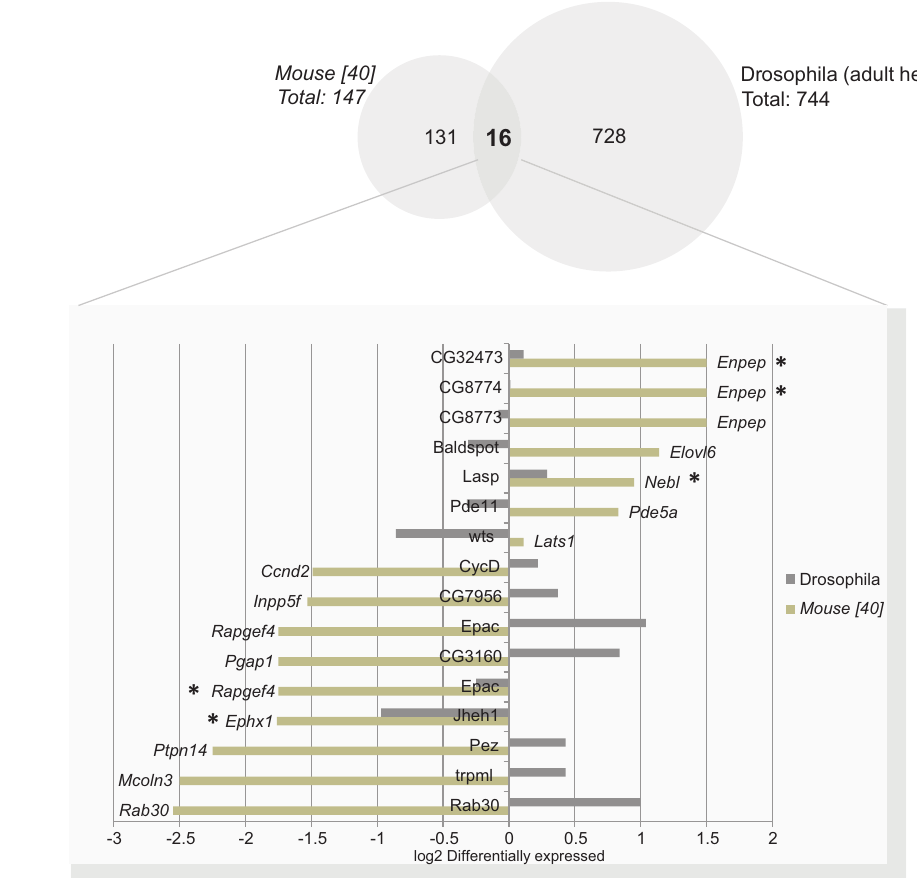
Figure 8. Comparison between Mouse and Drosophila Btk-dependent transcript: A) Venn-diagram: showing the overlap between Btk- dependent Transitional type 1 B-cells from Btk-defective mice [40] (a total of 147 differentially expressed genes) and the Btk-dependent transcripts found in Btk29A ficP Drosophila adult head (a total of 744 differentially expressed genes). B) ThirteenorthologoustranscriptsfoundinBtkKOmouse Transitionaltype1B-lymphocytesandinBtk29Adefectiveflies. Bar-graph showing the 16 transcripts, corresponding to 13 genes, found to be common in a homology search between the Btk-dependent transcripts found in the Btk KO mouse Transitional type 1 B-cells compared to its healthy control strain [40] and the current Drosophila Btk29A ficP study. Out of these 13 genes, 5 genes showed the same regulatory direction i.e. being up- or down-regulated in the respective Btk-defective strain (denoted as *).